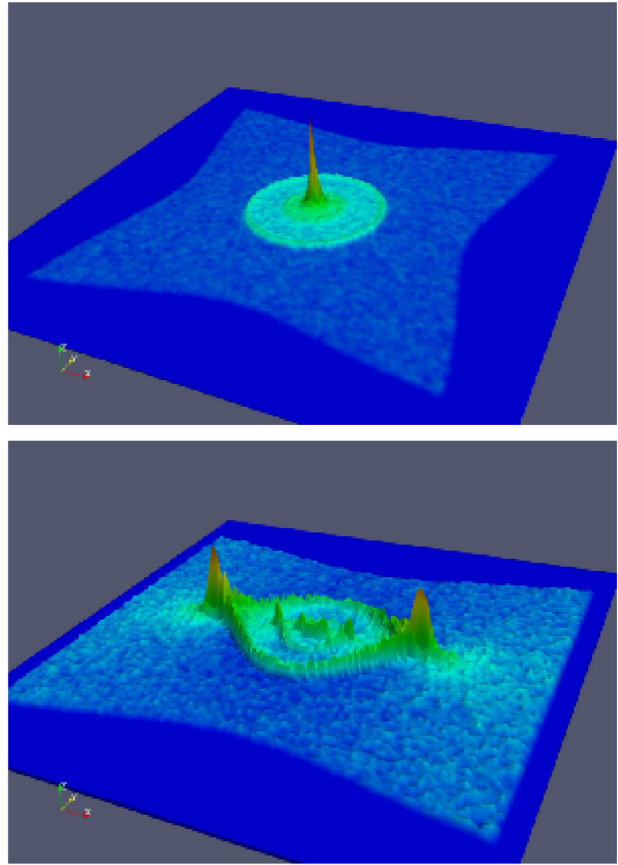
FIG. 13. Electron-cloud pinch snapshot during passage of a beam in a straight section (top) and a bending magnet (bottom).